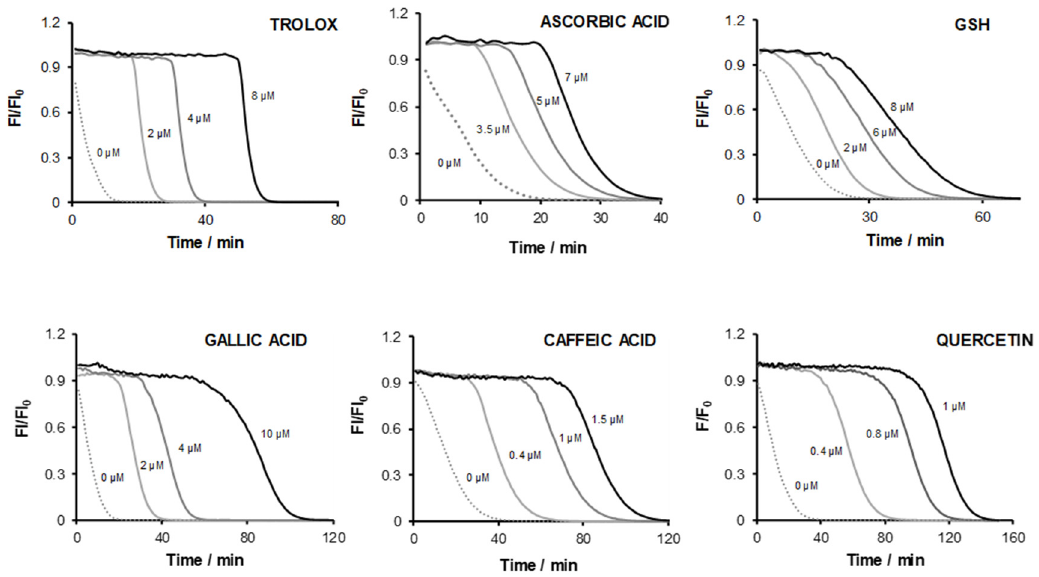
Figure 2. ORAC curves obtained for Trolox, ascorbic acid, reduced glutathione (GSH), gallic acid, caffeic acid and quercetin.